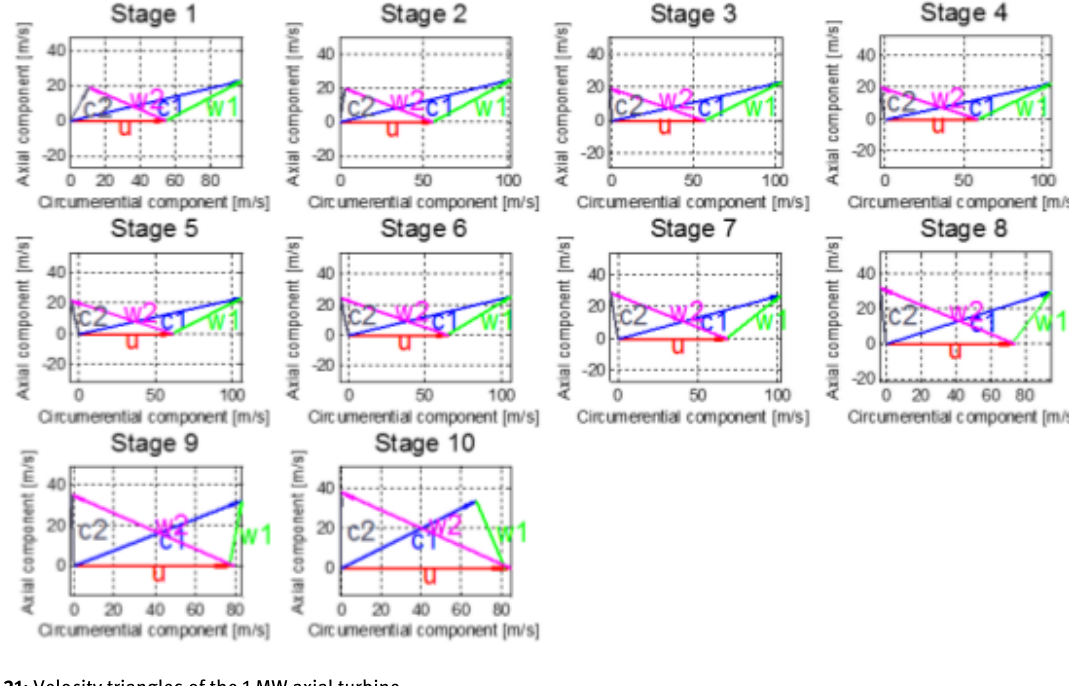
Figure 21: Velocity triangles of the 1 MW axial turbine.